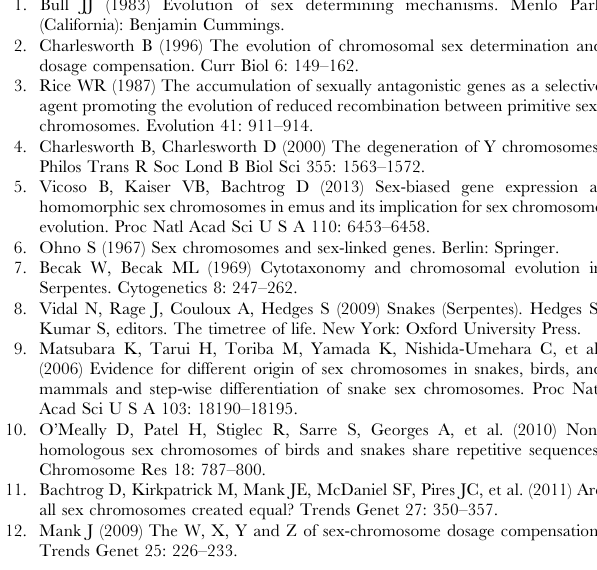
Table S5 Synonymous divergence K s between ZW paralogs using three other models to estimate K s . Table S6 List of confirmed and putative W-linked transcripts in pygmy rattlesnake. Female and male RNA- seq and DNA-seq reads were mapped to the de novo transcriptome using Bowtie2, and the resulting alignments were used to estimate expression levels (FPKM, with Cufflinks) and genomic male and female read counts. Transcripts with male/female read counts below 0.1 and female-specific expression were classified as putative W-derived sequences (only transcripts with at least 30 genomic female reads were considered in this analysis). The PCR confirmation of W-linkage of some of the transcripts is described in Figure S11. Table S7 Detecting male-driven and faster-Z evolution using three other models to estimate K a and K s . Median K a , K s , and K a /K s values for boa- Anolis , pygmy rattlesnake- Anolis and garter snake- Anolis comparisons are given for autosomal macrochromosomes and for chromosome 6/Z. All estimates of rates of evolution were obtained using KaKs_calculator. Table S8 Number of RNA-seq and DNA-seq reads generated for/used in this